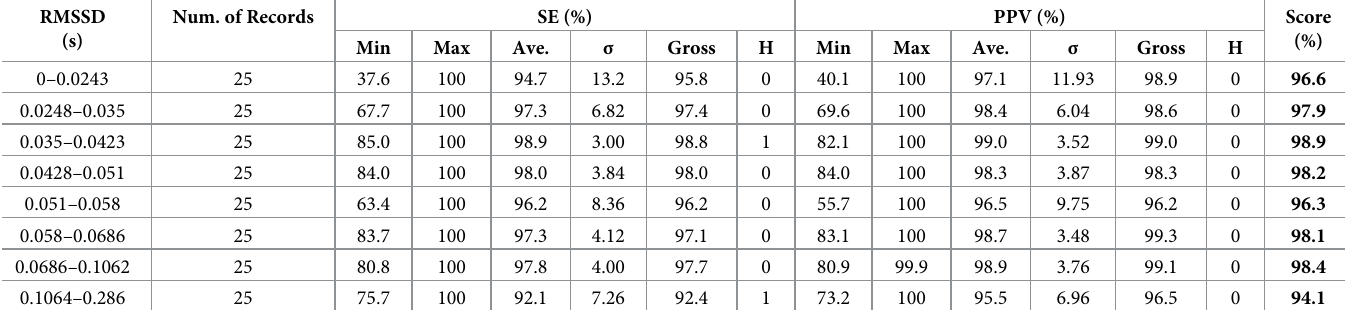
Table 3. Performance scores of challenge database grouped by RMSSD.